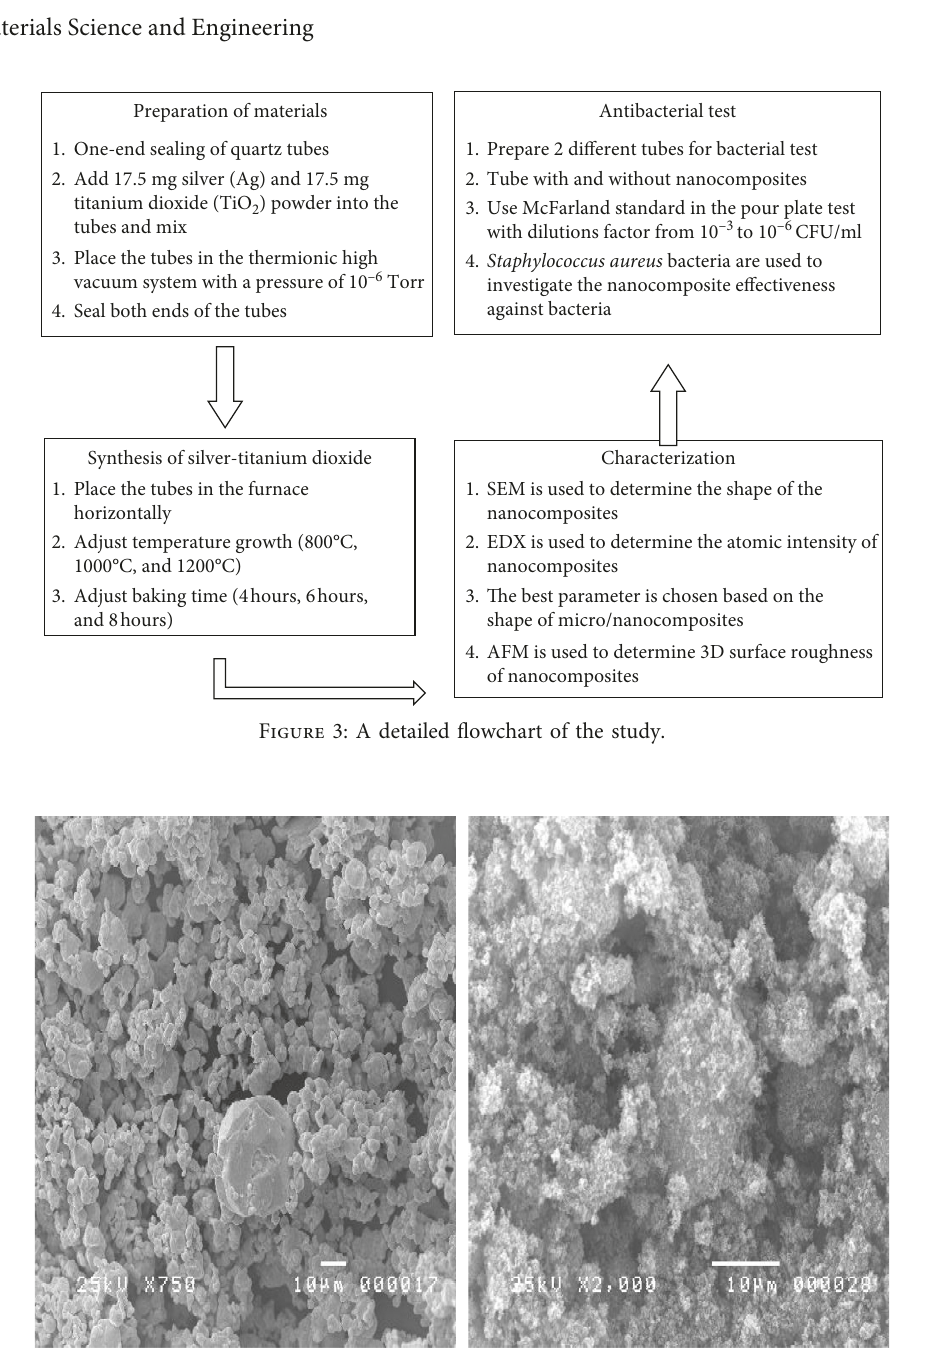
Figure 4: Silver material (a) and titanium dioxide material